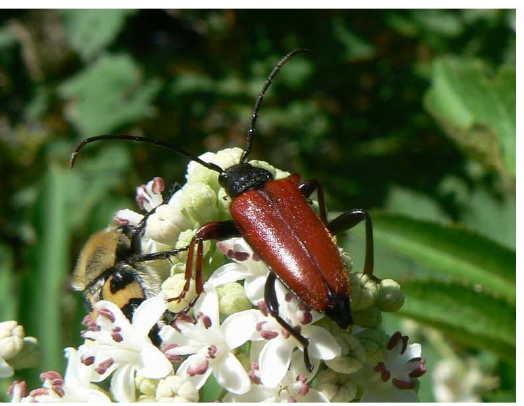
Figure 5. Stictoleptura erythroptera (Hagenbach, 1822) (photo: Milan Đ uri ć )